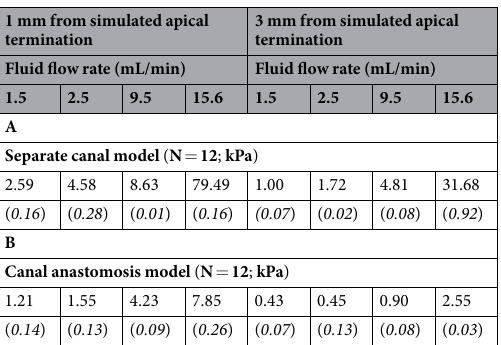
Table 1. Maximum apical fluid pressures generated from A . the separate canal model and B . the canal anastomosis model, by irrigant delivered at different flow rates (in mL/min) following the insertion of a side- vented needle to different depths (in mm) from the simulated apical termination of the tested canal. Data for the adjacent canal are not shown. Values represent medians ( interquartile range